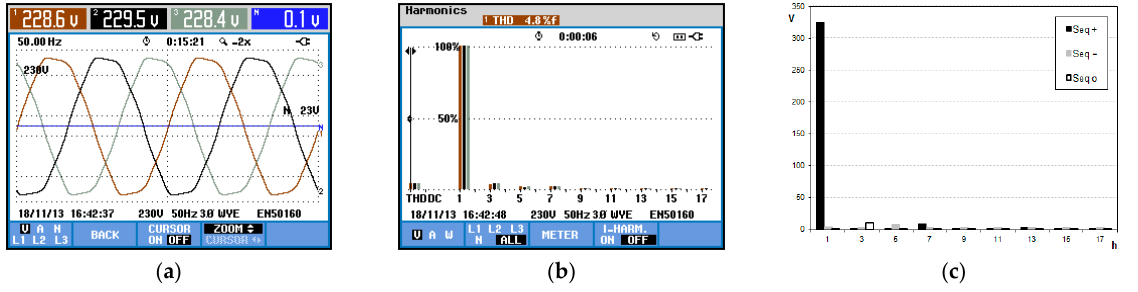
Figure 26. Case 1—system without filters: ( a ) three-phase voltages; ( b ) harmonic spectrum of the voltages; ( c ) harmonic spectrum of the voltage sequence components (maximum values).